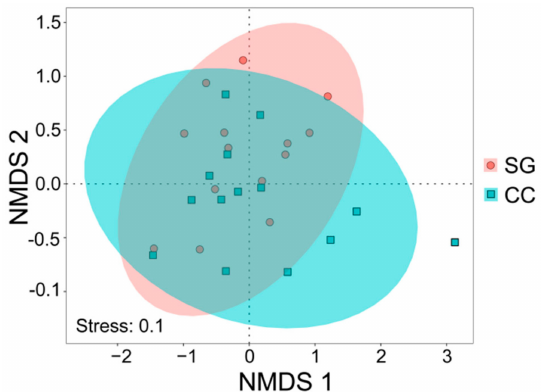
Figure 6. Nonmetric multi-dimensional scaling (NMDS) of plant species (Log (number of individuals + 1) was used to transform plant species data; distance = “jaccard”). SG: small gaps ( n = 15); CC: closed canopy ( n = 14, there is a plot missing the main plant